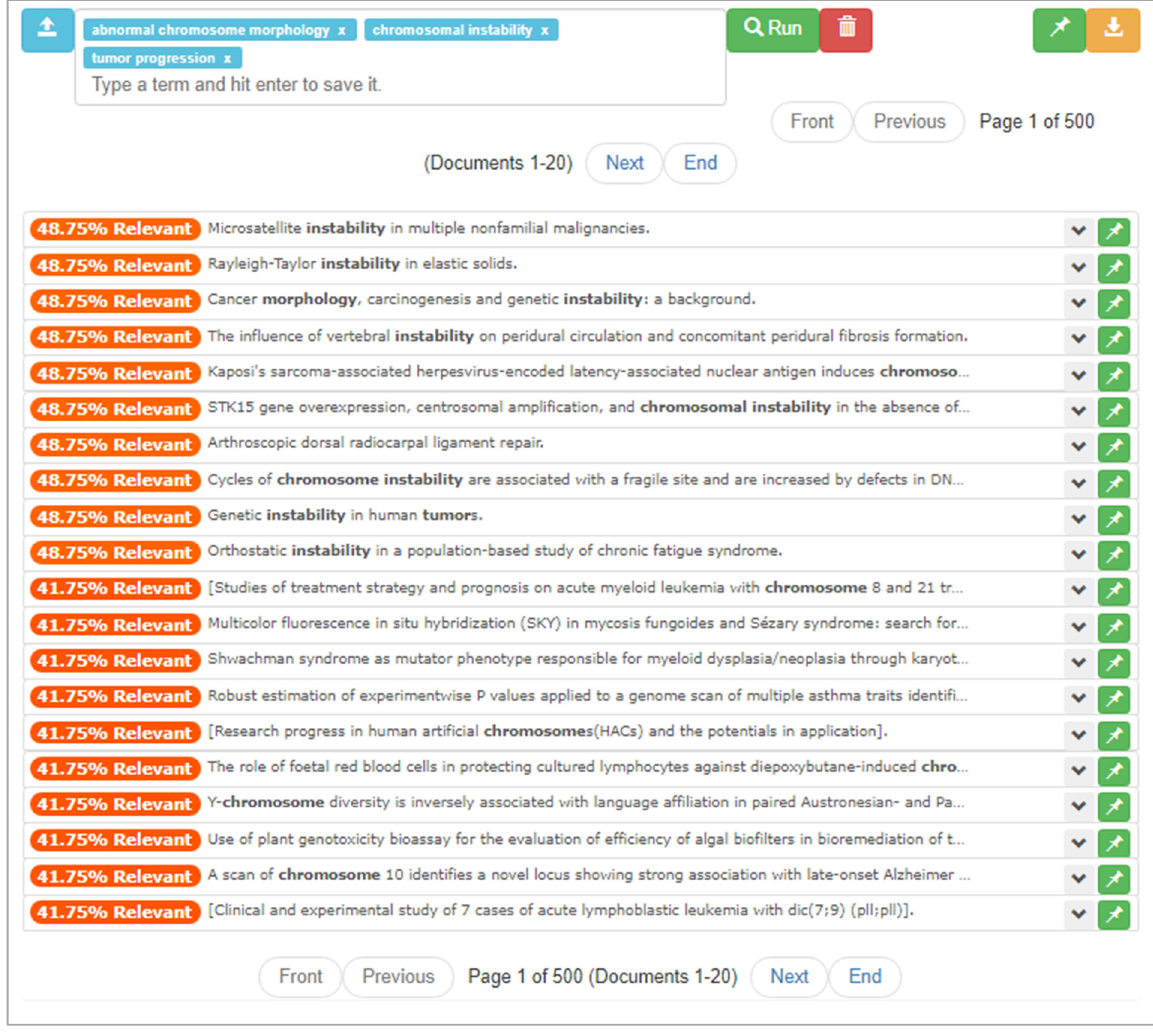
Figure 12. ONTSI after running a new search after the user took advantage of mediation opportunities presented in the generation of the query items.